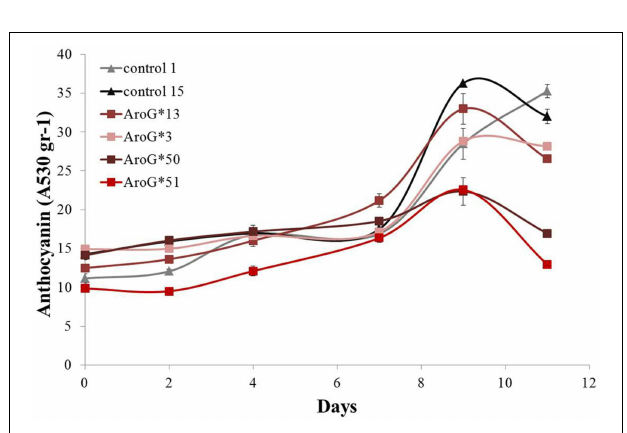
FIGURE 4 | Effect of AroG * transformation on total anthocyanin accumulation in the Gamay cell cultures. The increase in total anthocyanin concentration was determined as the increase in OD absorption at 530nm. Bars indicate standard errors ( n = 3 ).